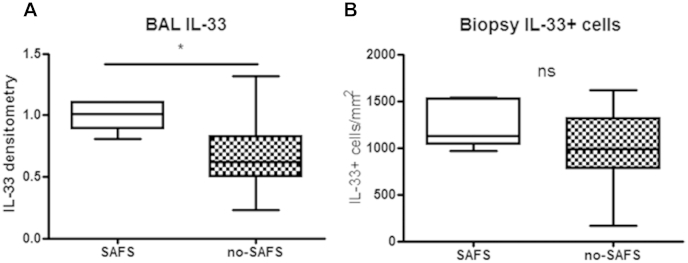
IL-33 levels were quantified in BAL fluid by means of Western blotting (A), and IL-33+ cells stained by means of immunohistochemistry were quantified in the submucosa of endobronchial biopsy specimens (B; n = 14 children). Group differences were assessed by using the Mann-Whitney U test: *P < .05. ns, Not significant.